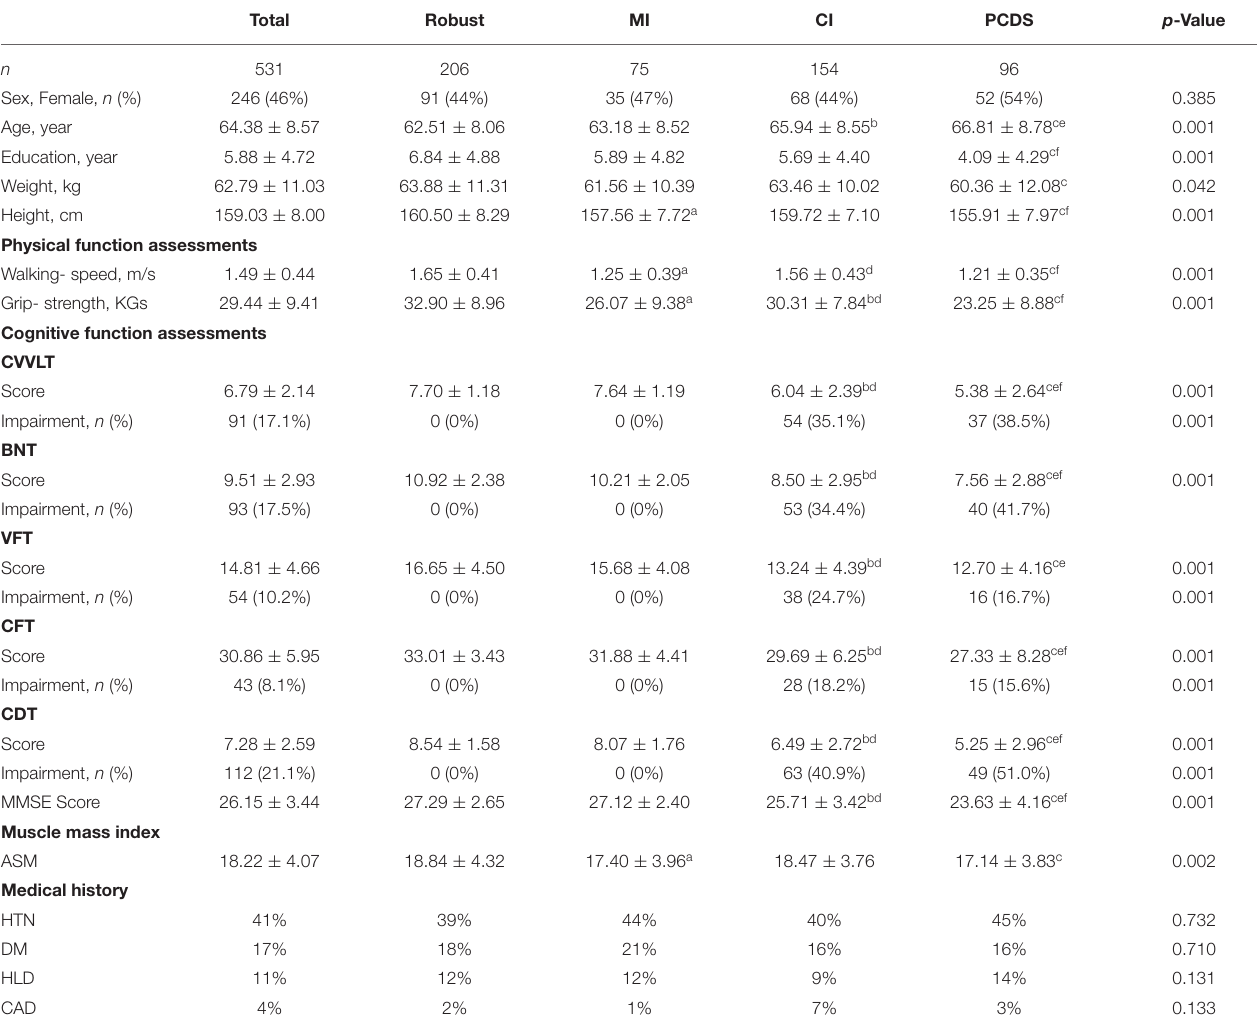
TABLE 1 | Demographic characteristics of four categories at